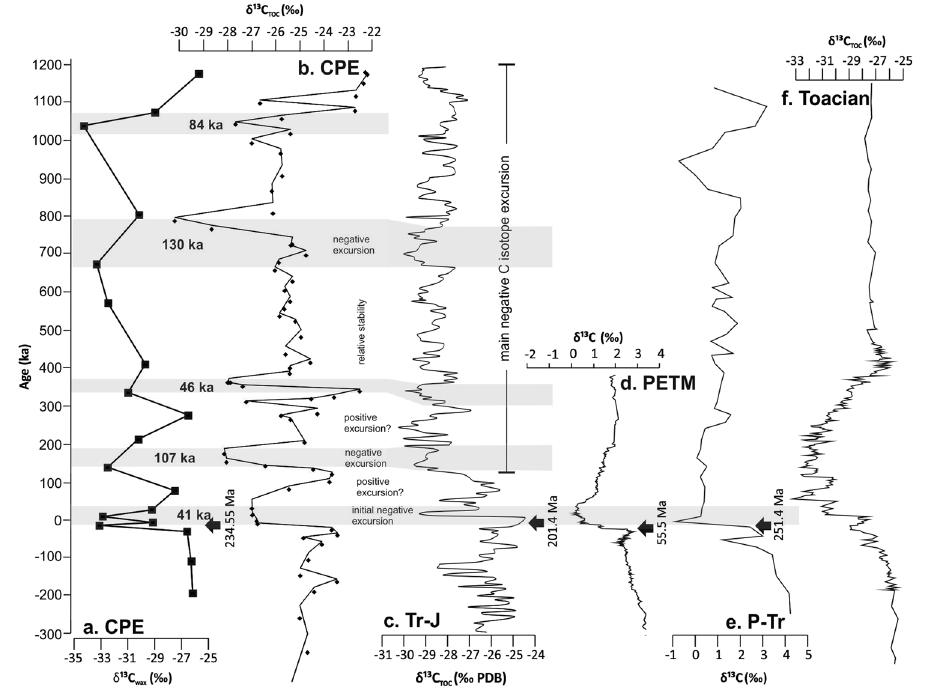
Figure 4. A comparison between the CPE negative CIE (this study) and other negative CIEs in the Phanerozoic. ( a ) Devon CPE δ 13 C wax (this study). ( b ) Devon CPE δ 13 C TOC (this study). ( c ) St Audrie’s Bay End Triassic Extinction (ETE) δ 13 C variations in organic matter 38, 39 . ( d ) δ 13 C record of marine bulk carbonate from ODP 690 over the Paleocene–Eocene Thermal Maximum (PETM) 42 . ( e ) End Permian δ 13 C record of marine bulk carbonate from southern China 40 . ( f ) Early Jurassic (Toarcian) δ 13 C variations in organic matter from Yorkshire (UK) 41 . 0 ka is set as the onset of all isotope excursions. The CPE onset is taken as the Julian 1–2 boundary at 234.55 Ma 4 . The floating chronology for the WP borehole 1 is formed from the tuning of the Ca/Ti data to the 405 ka orbital cycle (see Fig.